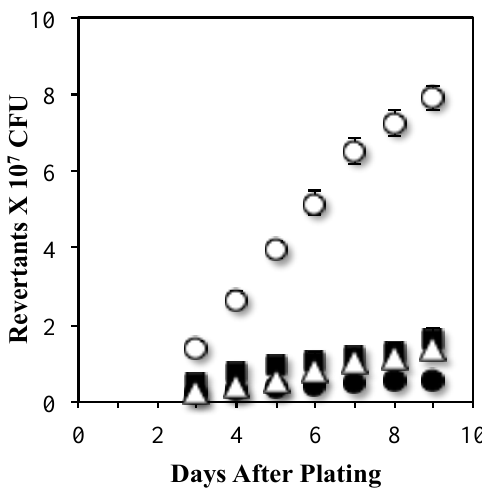
Figure 2. The stationary-phase mutagenesis requires PolI. The accumulation of Leu + revertants of the YB955 (parental strain) ( ○ ), AMP100 ( polA ) ( ■ ), YB9801 ( mfd ) (●), and AMP101 ( polA mfd ) (Δ) B. subtilis strains were obtained as described in Materials and Methods. Data represent the average of three separate tests ± standard error of the mean (SEM).